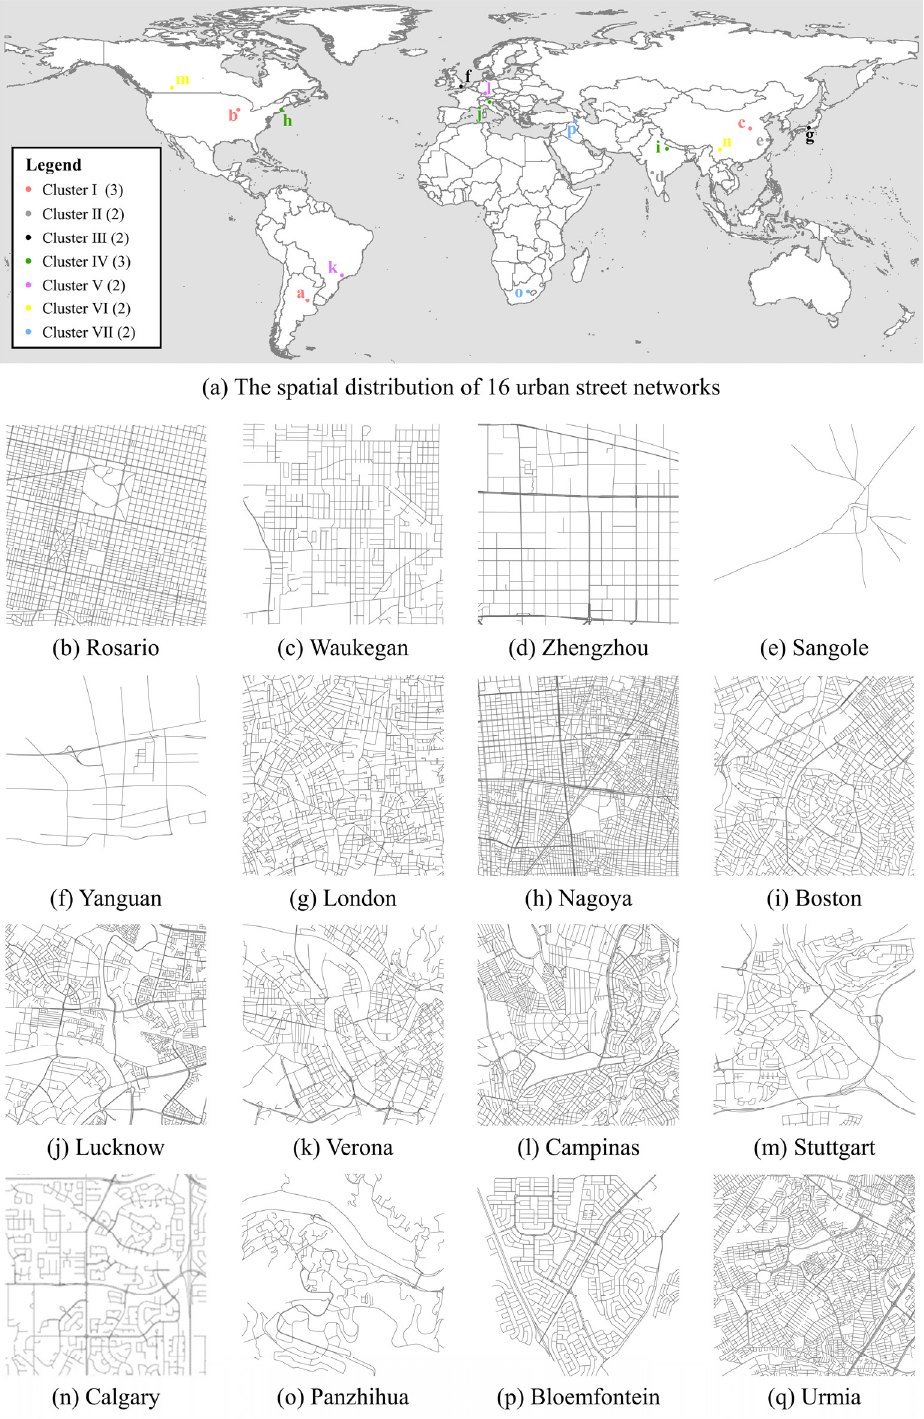
Figure 3. The detailed view of 16 typical urban street networks (each was visualized in a 5 km × 5 km grid).